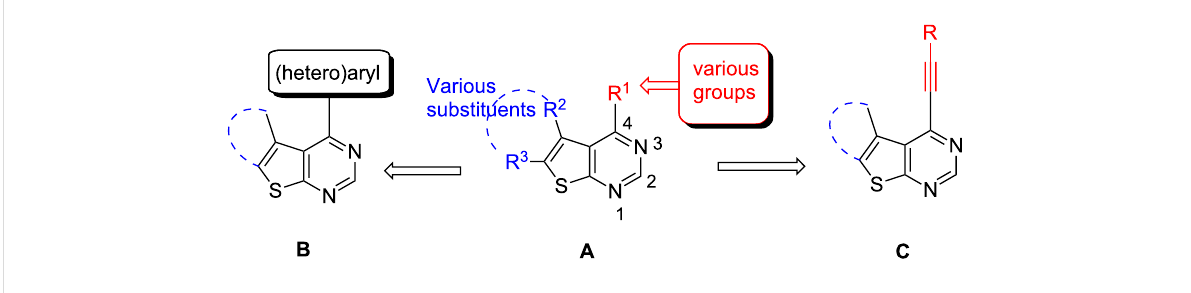
Figure 1: Diversity-based thieno[2,3- d ]pyrimidine scaffold [7].